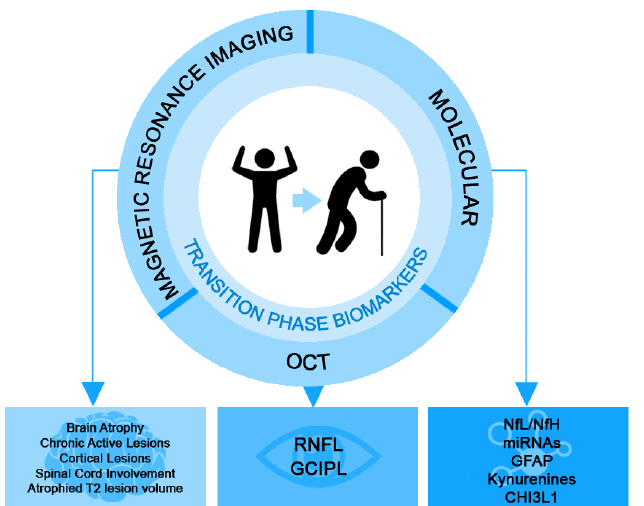
Figure 1. Proposed biomarkers with prognostic value for the conversion of RRMS to PMS (CHI3L1: chitinase 3-like-1; GFAP: glial fibrillary acidic protein; GCIPL: ganglion cell–inner plexiform layer; Nfl: neurofilament light chain; NfH: neurofilament heavy chain; OCT: ocular coherence tomography; RNFL: retinal nerve fibre layer).